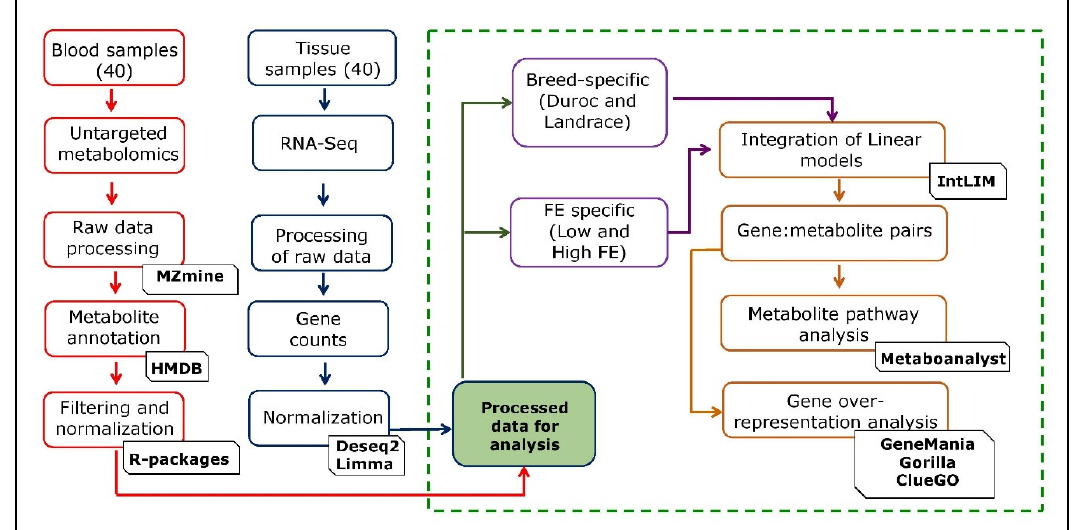
Figure 1. Schematic representation of the study design and analysis steps.